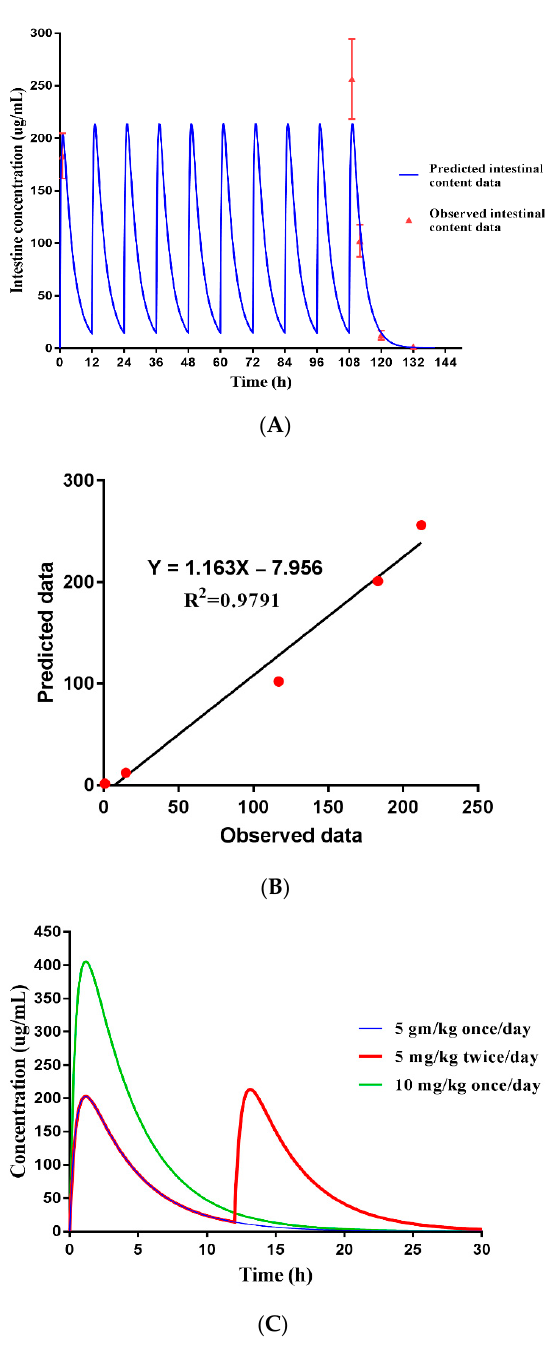
Figure 8. The fitting of observed ENR concentration in intestinal contents data with predicted data of the PBPK model (5 mg/kg b.w. twice a day for five days) ( A ), the liner regression analysis of the PBPK mode ( B ), and the predictive PK curves at different doses ( C ). The predicted ENR concentrations in intestinal content were well verified by five-observed data ( r = 0.9894).